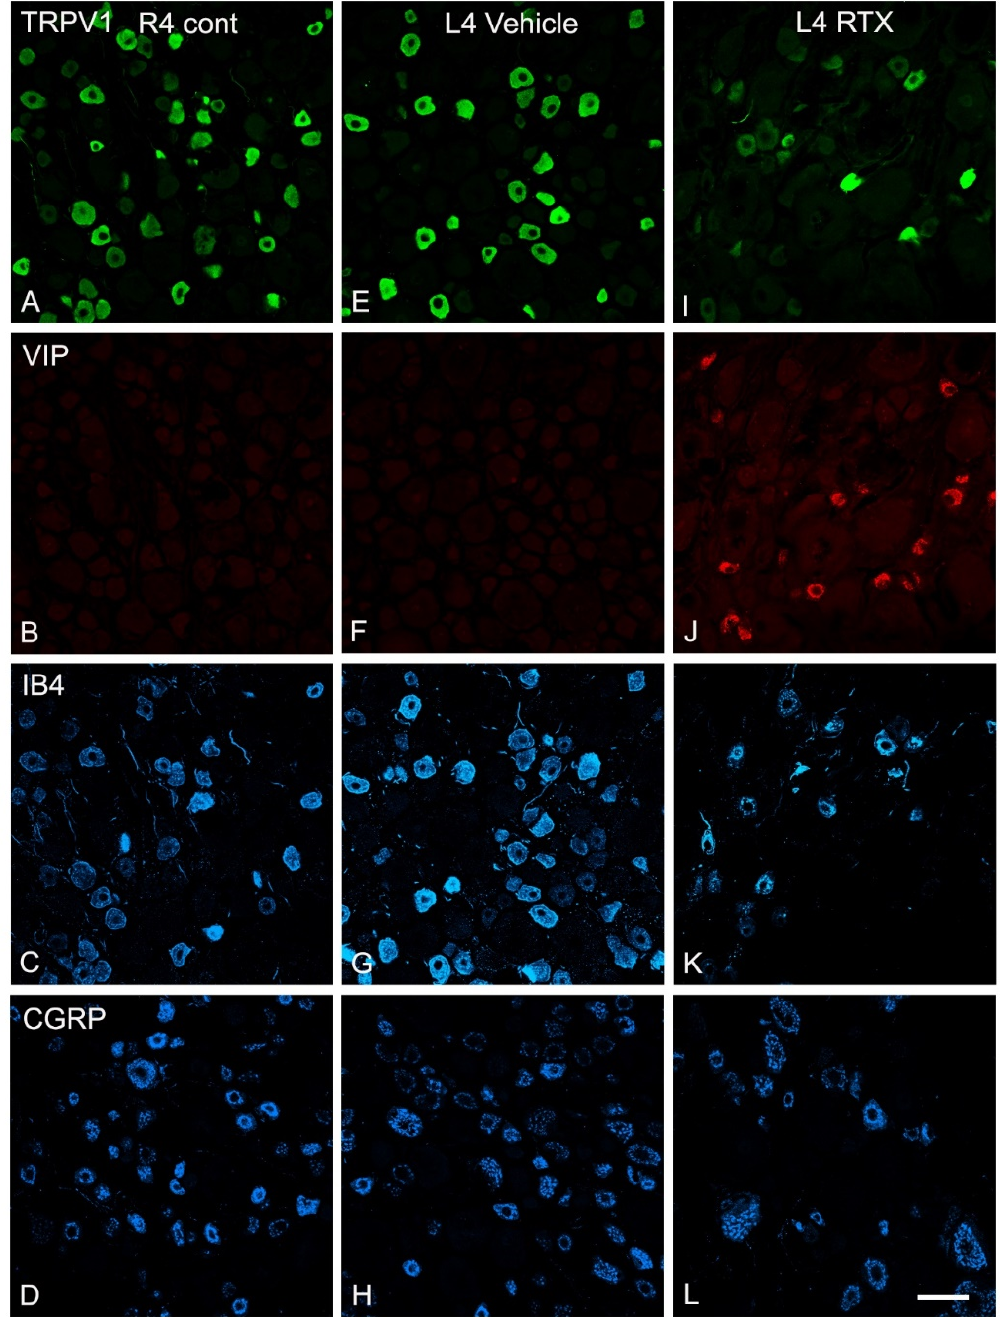
Figure 6. Triple immunofluorescent labelling for TRPV1, VIP, IB4 and CGRP in control right L4 DRG (R4 cont, A – D ) and left L4 DRGs following 14 days of the intraplantar injection of vehicle ( E – H ) or 0.002% RTX ( I – L ) in the left hind paw. RTX treatment caused a remarkable reduction in the number of TRPV1+ neurons ( I ), IB4+ neurons ( K ) and CGRP+ neurons ( L ) in the L4 DRG compared to the right control (R4) and vehicle-treated L4 DRGs ( A , C , D , E , G , H ). In contrast, the number of VIP+ neurons were increased in the RTX-treated L4 DRG ( J ) compared to the right control (R4) or vehicle-treated L4 DRGs ( B or F ). Scale bar = 50 µm.